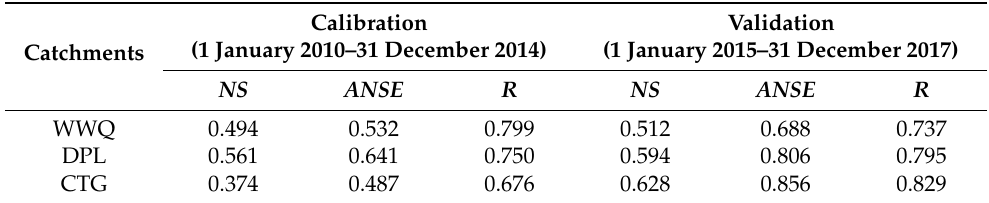
Table 2. Performance of the MISDc model in the calibration and validation periods for the three basins.